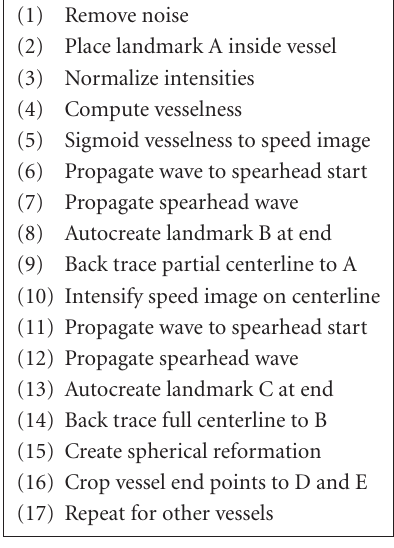
Figure 2: Steps of the algorithm needed to track and display vessels.